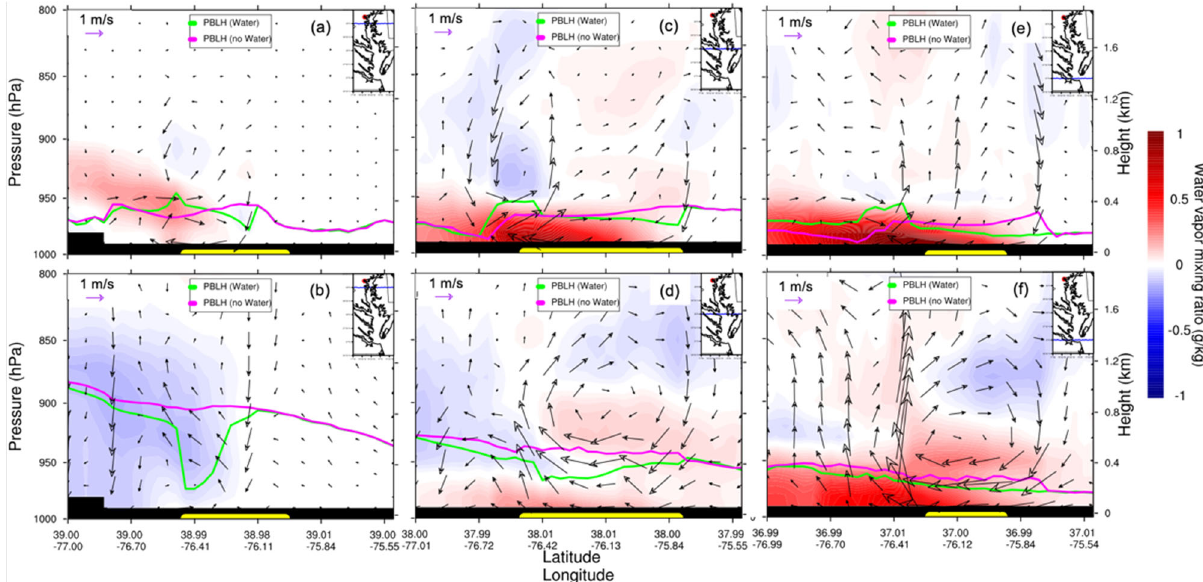
Figure 14. WRF–Chem ‐ simulated water vapor mixing ratio vertical cross section (from west to east) differences (water minus nowater, night: ( a – c ); day: ( d – f )). The overlaid streamline is the corresponding surface wind difference. The green curve is the PBLH of water; the pink curve is the PBLH of nowater; CB is represented by the yellow bar. The upright insert map shows the location of the vertical cross section (blue line). Note that vertical wind is magnified by 50 times for the illustration. Daytime is defined as 1000–0000 UTC (or 06:00–20:00 local time); nighttime is defined as 0000–0900 UTC (or 00:00–06:00 and 20:00–00:00 local time).